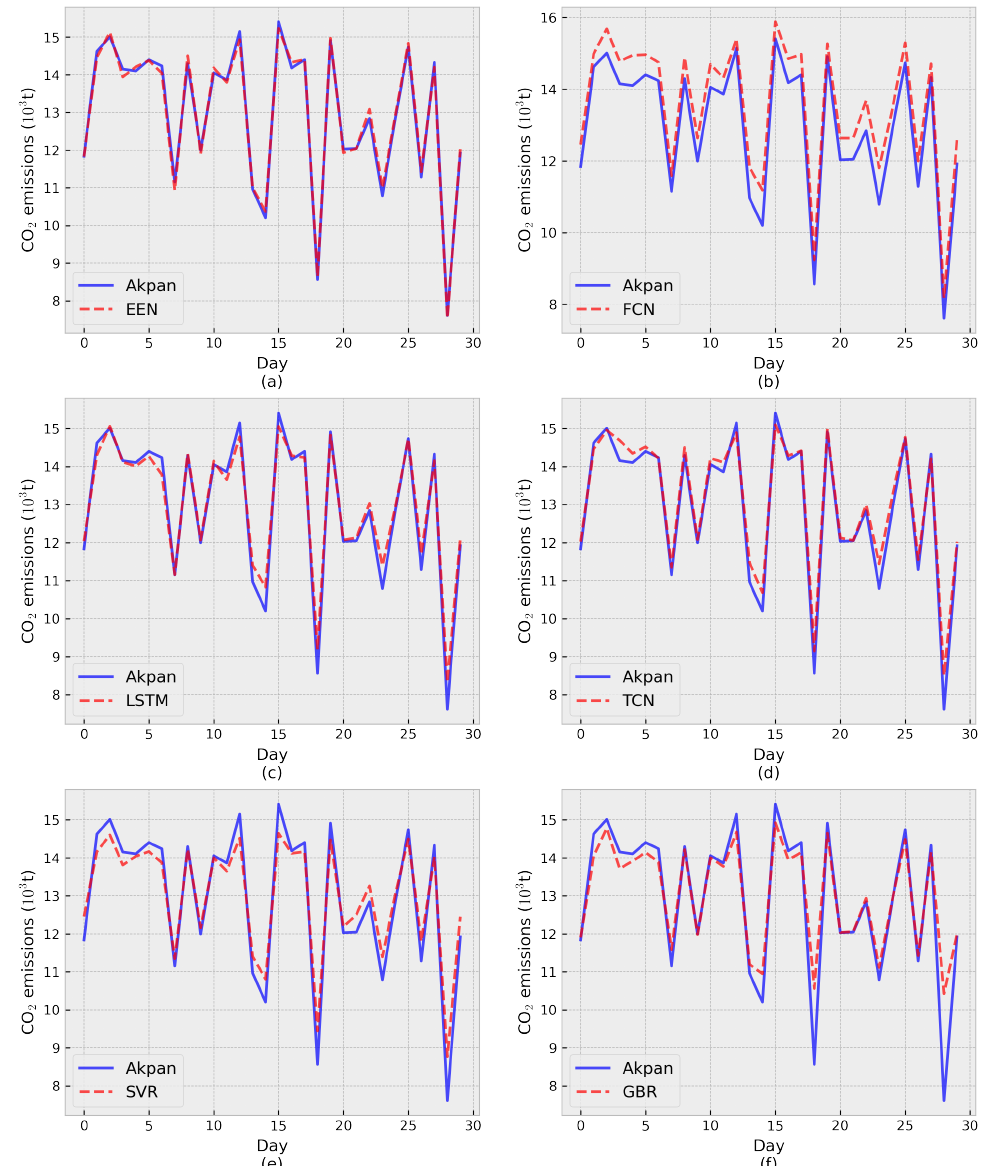
Figure 13. Comparison of estimated daily CO 2 emissions. ( a – f ) compare the estimated daily CO 2 emissions between Akpan and EEN , FCN , LSTM , TCN , SVR , and GBR ,